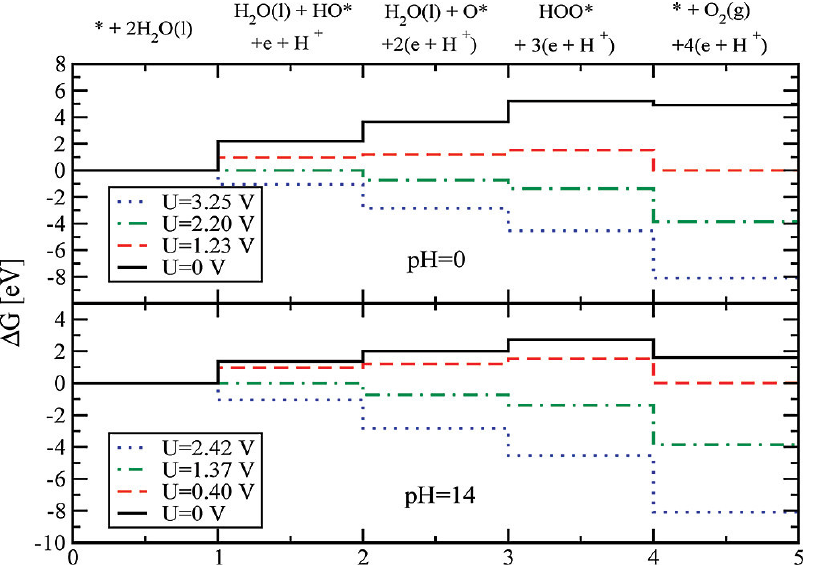
Figure 4. In the case of S 1 surface termination, the free energies of the intermediates at pH = 0(14) (U = 0, 1.23(0.40), and 2.20(1.37) V) are shown. Some reaction steps are uphill in free energy at the equilibrium potential ( U = 1.23(0.40) V). All reaction steps are downhill in free energy at pH = 0(14). The corresponding values of the redox potential is 2.20(1.37) V. For the photogenerated holes the corresponding values of redox potential vs. NHE in the valence band TiO 2 (rutile) in contact with H 2 O under irradiation at pH = 0(14) are also compared. (Reprinted from ref. [49] with permission from the American Chemical Society. Copyright © 2008, American Chemical Society).